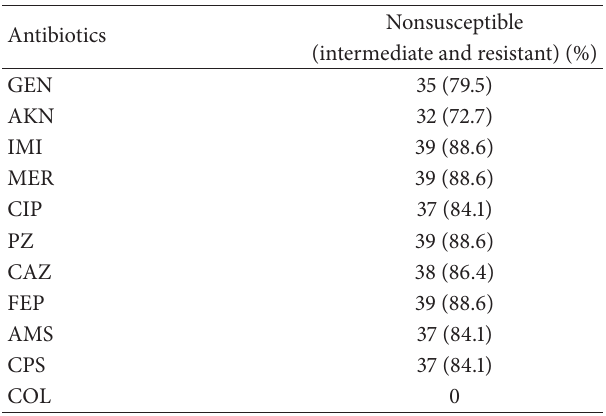
Table 2: Antimicrobial susceptibility (disc diffusion) of 44 ACB complex isolates recovered from 38 ICU